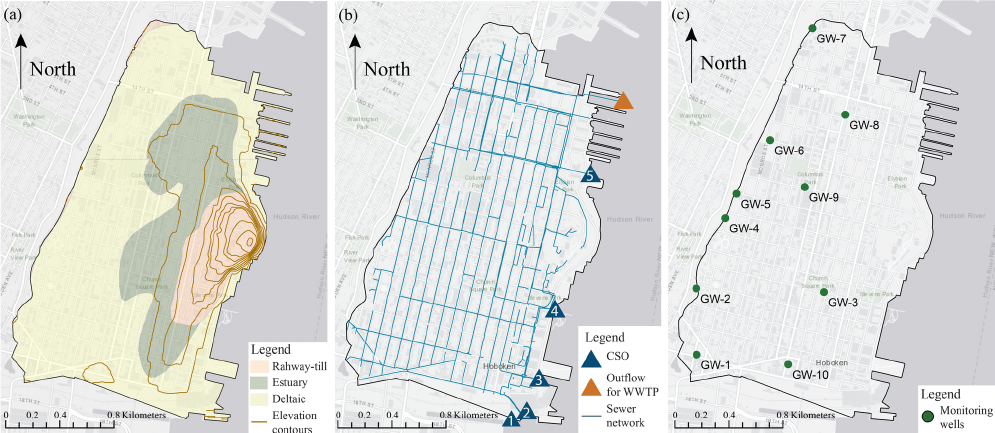
Figure 2. Maps of the study area showing: ( a ) the city plan with the shallow geology and the elevation [50]; ( b ) the sewer network with the outflows; and ( c ) the locations of the groundwater monitoring wells. The datum in parts ( a ) and ( c ) is NAVD 88. The map of the sewer system was provided by the North Hudson Sewerage Authority (NHSA).